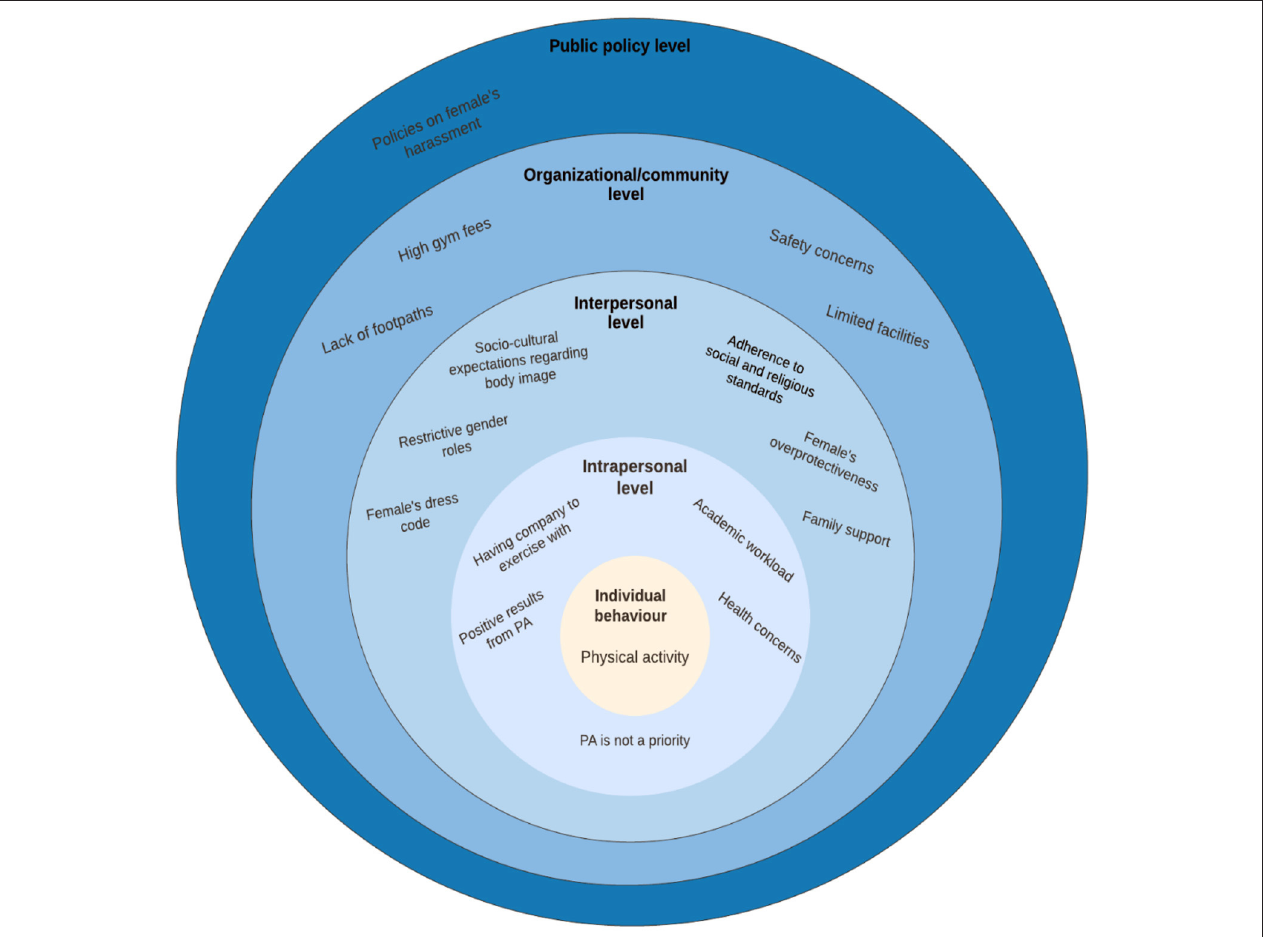
FIGURE 1 | Social-ecological levels showing the barriers and motivators to females’ engagement in physical